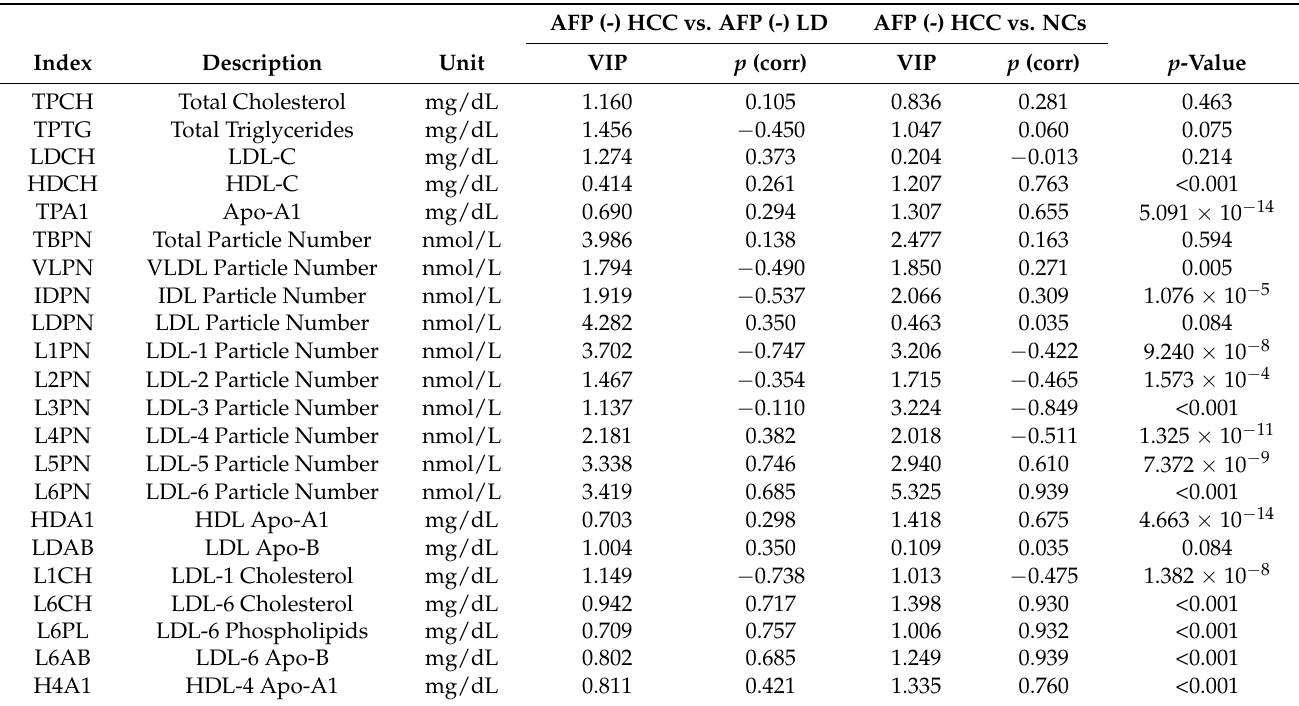
Table 3. Summary of the lipoprotein subfraction statistical data from OPLS-DA analysis from AFP (-) HCC patients, AFP (-) liver disease (LD) patients, and normal controls (NCs).